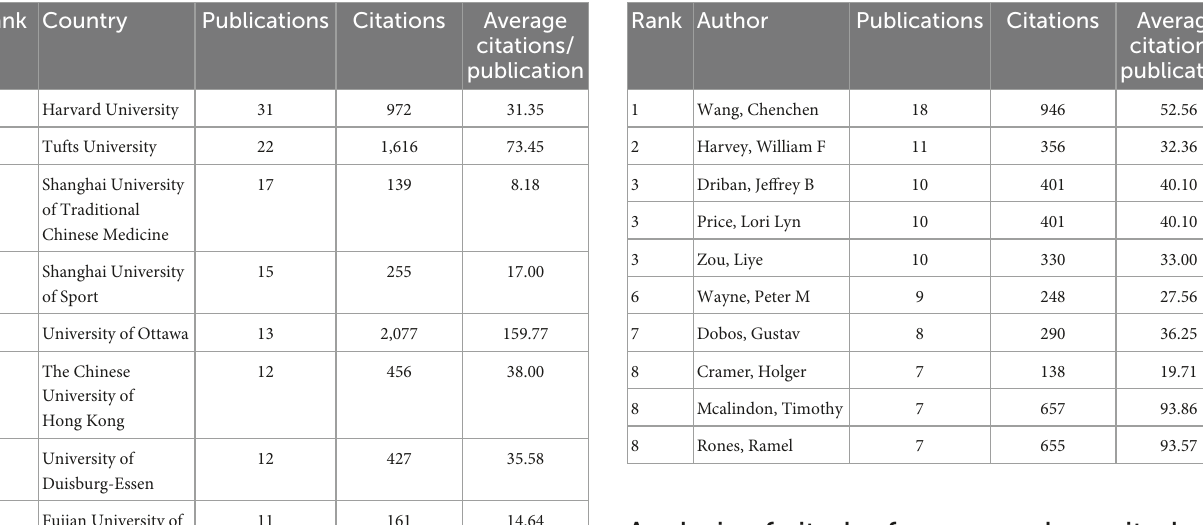
TABLE 5 Top 10 authors for publications on traditional Chinese exercises for musculoskeletal disorders.